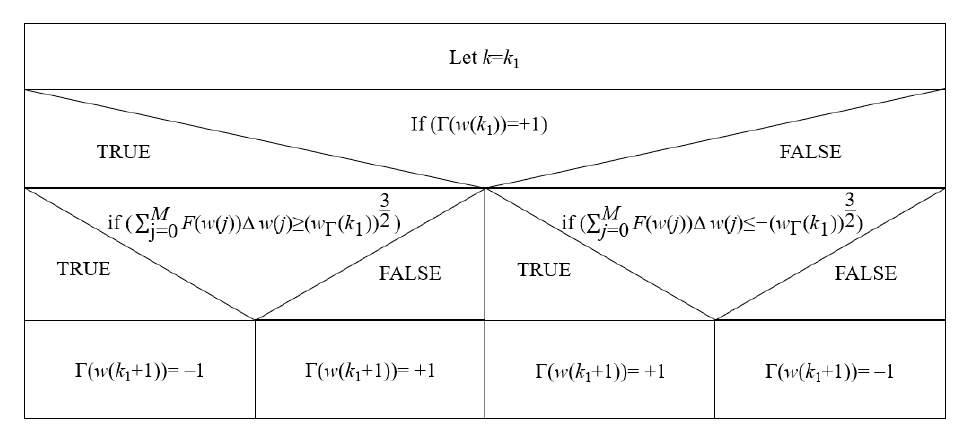
Figure 1. The selection law of Γ ( w ( k )).